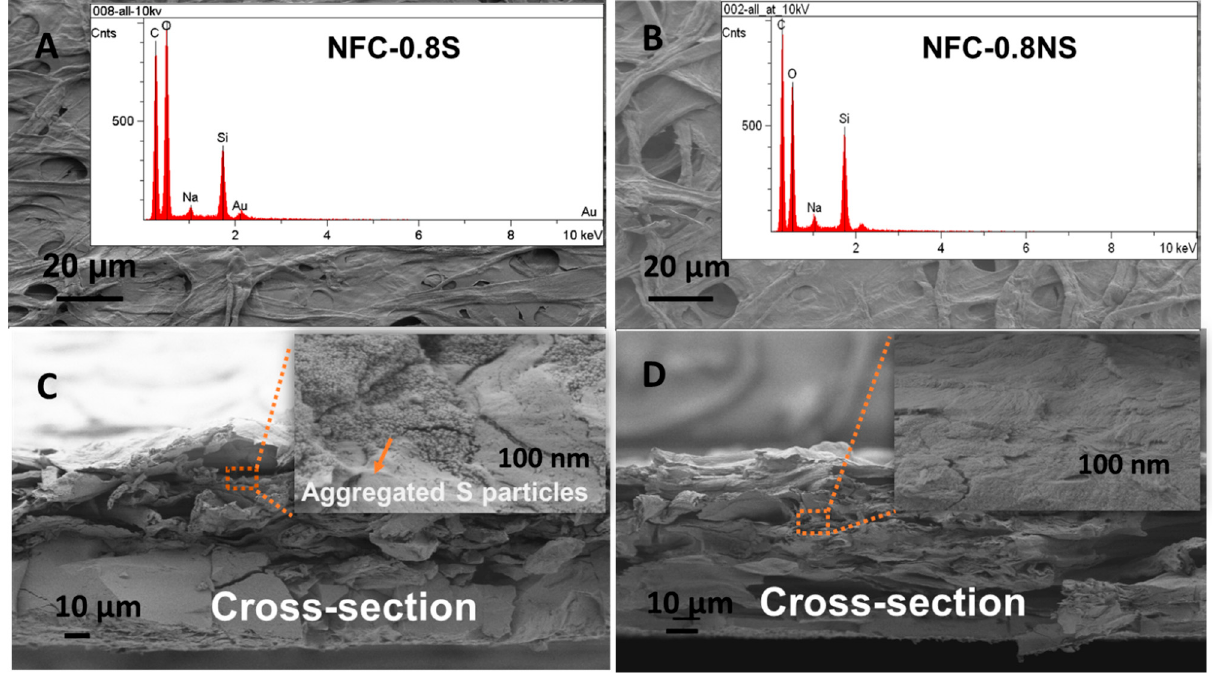
Figure 8. SEM images of ( A ) MFC-0.8S with EDS spectra (inset) and ( B ) MFC-0.8NS with EDS spectra (inset), and cross-section images of ( C ) MFC-0.8S and ( D ) MFC-0.8NS with magnified images (inset).